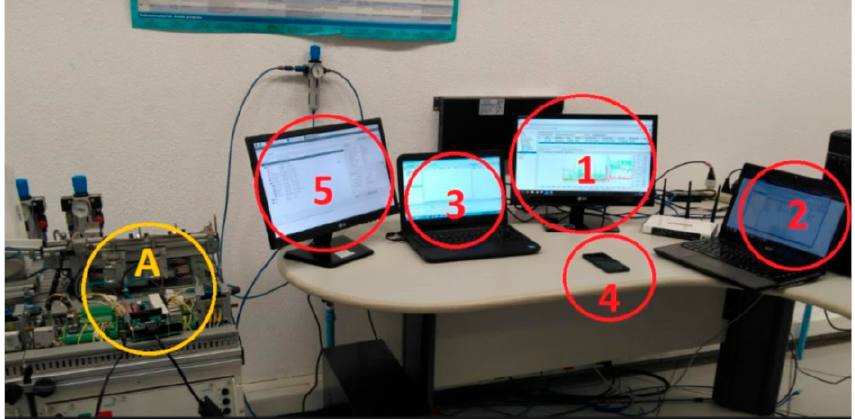
Figure 8. External OPC UA clients (1 to 4) and internal OPC UA client (5) connected to the OPC UA server.